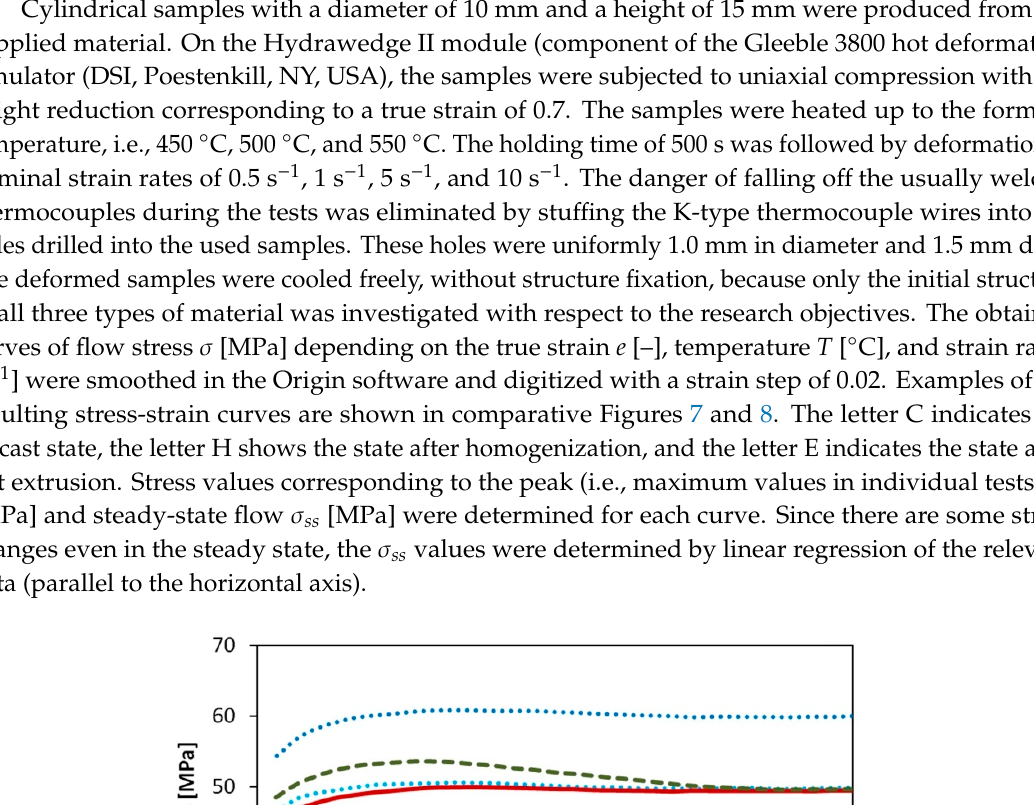
Figure 6. Disintegrated intermetallic phases in the extruded rod.